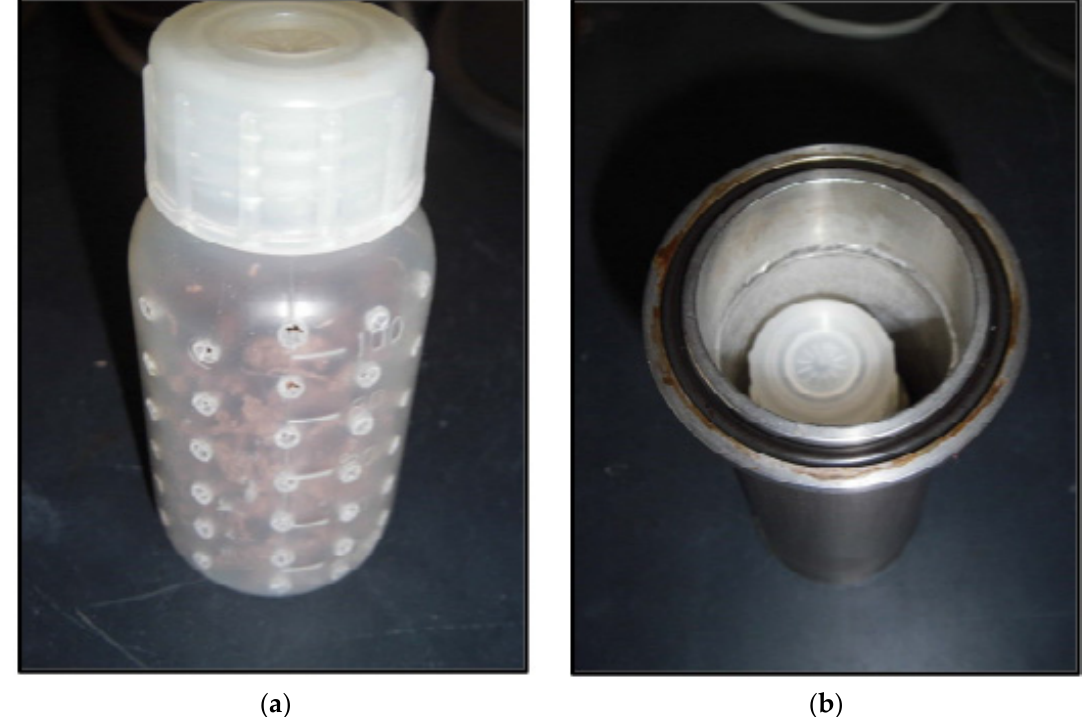
Figure A2. ( a ) Put pulp in a polypropylene plastic bottle, and ( b ) then put the plastic bottle into the reactor.